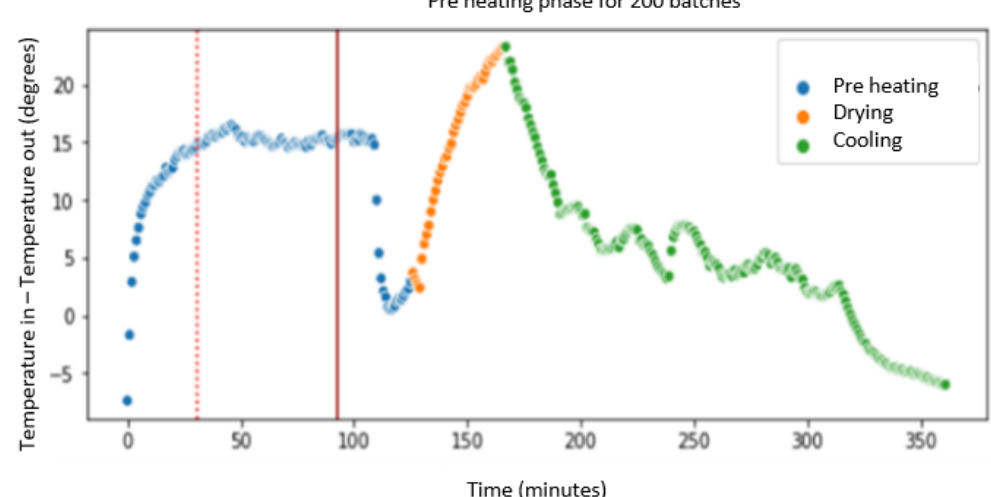
Figure 11. Average of the measurements of the 200 batches, time vs. temperature. Potential time savings in the preheating process shown by vertical lines.